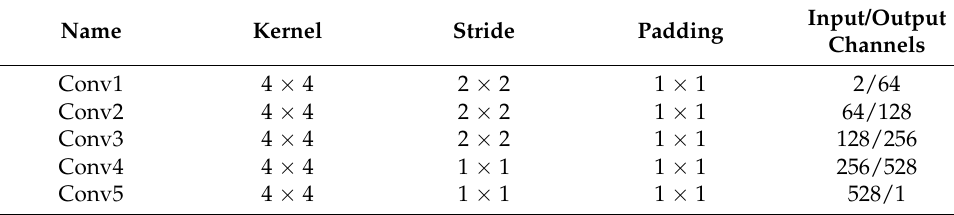
Table 5. The structure of the discriminator used in UA-GAN (Stage 2).